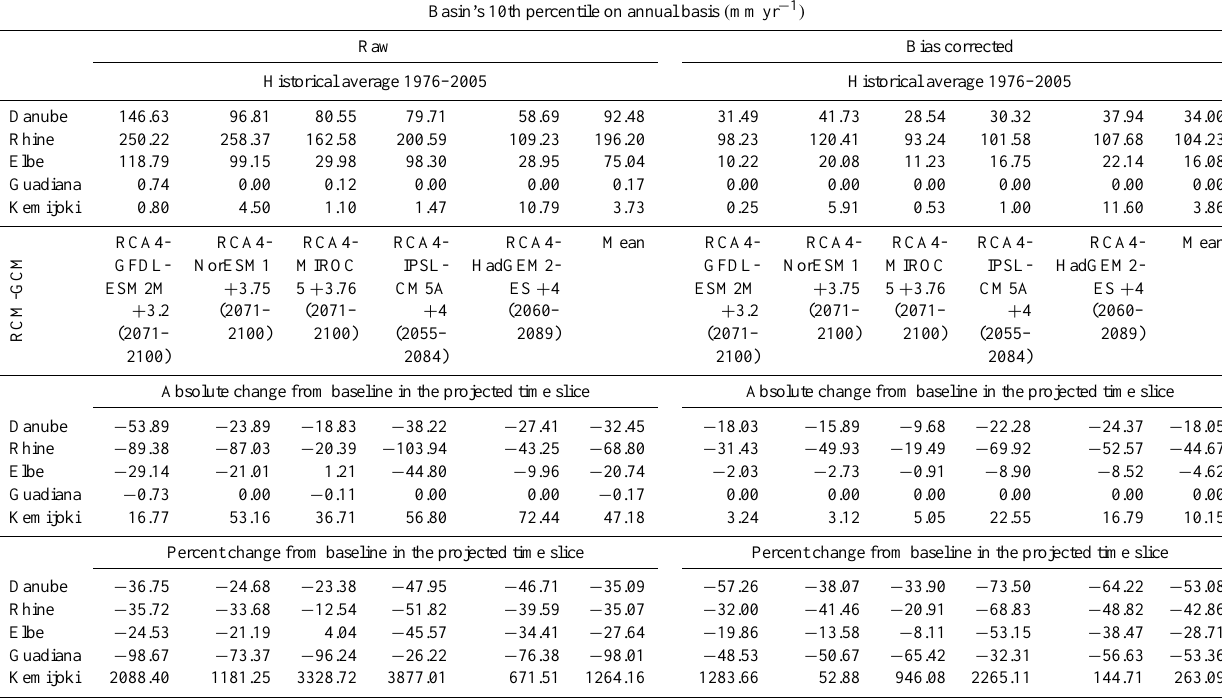
Table 3. Basin’s 10th percentile of runoff production, derived on an annual basis, for raw and bias adjusted Euro-CORDEX data.